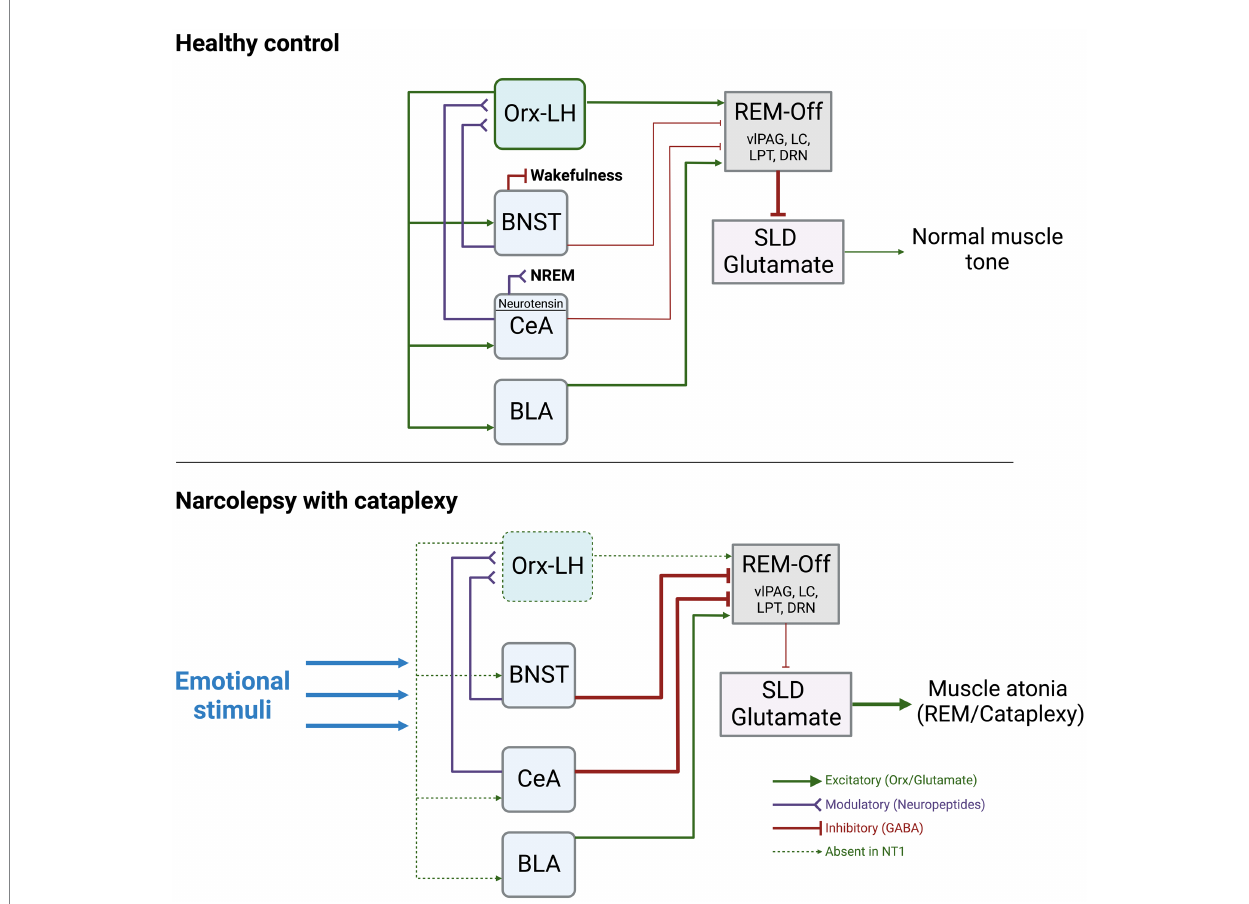
FIGURE 1 Summary of the known functional connections between AMY, Orx-LH neurons, REM-off promoting neurons, and the SLD. The thickness of the lines indicates hypothesized strengths and activity levels of connections. Under normal conditions, stimulation of BNST-GABA neurons can trigger wakefulness, and stimulation of CeA-Neurotensin neurons can increase NREM sleep. The BNST and CeA send modulatory neuropeptide (and inhibitory GABAergic) inputs to Orx-LH neurons, as well as inhibitory GABAergic projections to REM-Off regions (including vlPAG, LC, DRN, LPT). BLA neurons send excitatory glutamatergic projections to REM-Off neurons. REM-Off neurons inhibit SLD glutamate neurons that generate muscle atonia such as during REM under normal conditions. In NT1, with loss of Orx, there is an imbalance of excitatory/inhibitory input to REM-off regions. Inhibitory input from AMY to REM-Off neurons may be more pronounced as a consequence, resulting in less disinhibition (excitation) of SLD glutamate neurons. SLD glutamate neurons typically promote muscle atonia, and can lead to cataplexy upon being released from inhibitory control during wakefulness. Figure created using